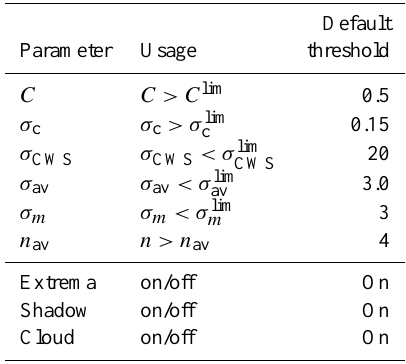
Table 2. Parameters that can be used for filtering the height estimate data and the default values. In the ACM output, both the original un- filtered single-pixel heights and the filtered MAW-averaged heights are given. See text for